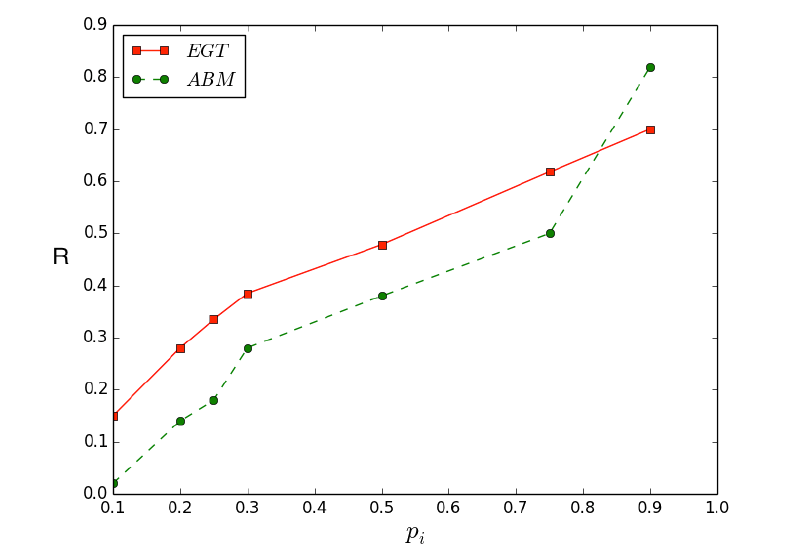
Figure 4. Comparison between the outcomes achieved in the model described in [9], defined as ABM (i.e. Agent-Based Model) in the legend, and those achieved in this work, defined as EGT (i.e., Evolutionary Game Theory) in the legend. Amount of rational agents R ( + 1 indicates rational, − 1 irrational). In particular, this analysis aims to evaluate if one-round challenges analyzed in [9] behave like an EGT-based model with a varying p r (i.e., probability of success of rational agents). Results have been averaged over 100 simulation